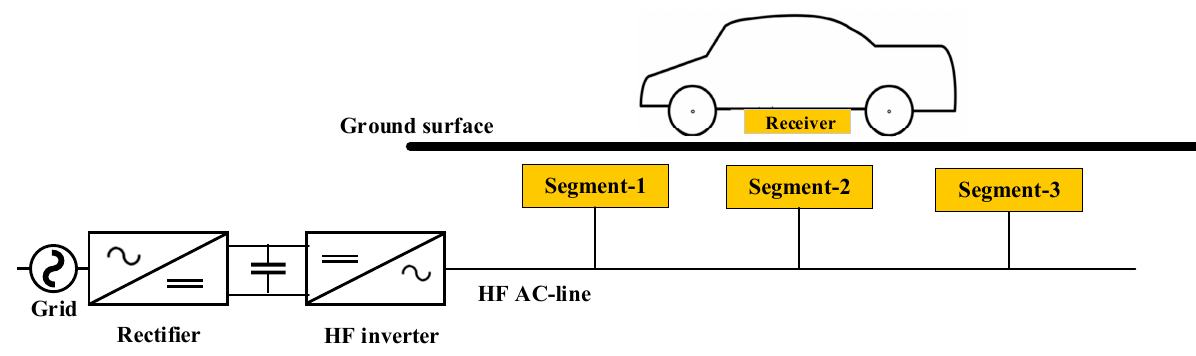
Figure 8. Arrangement of reflexive segmentation.